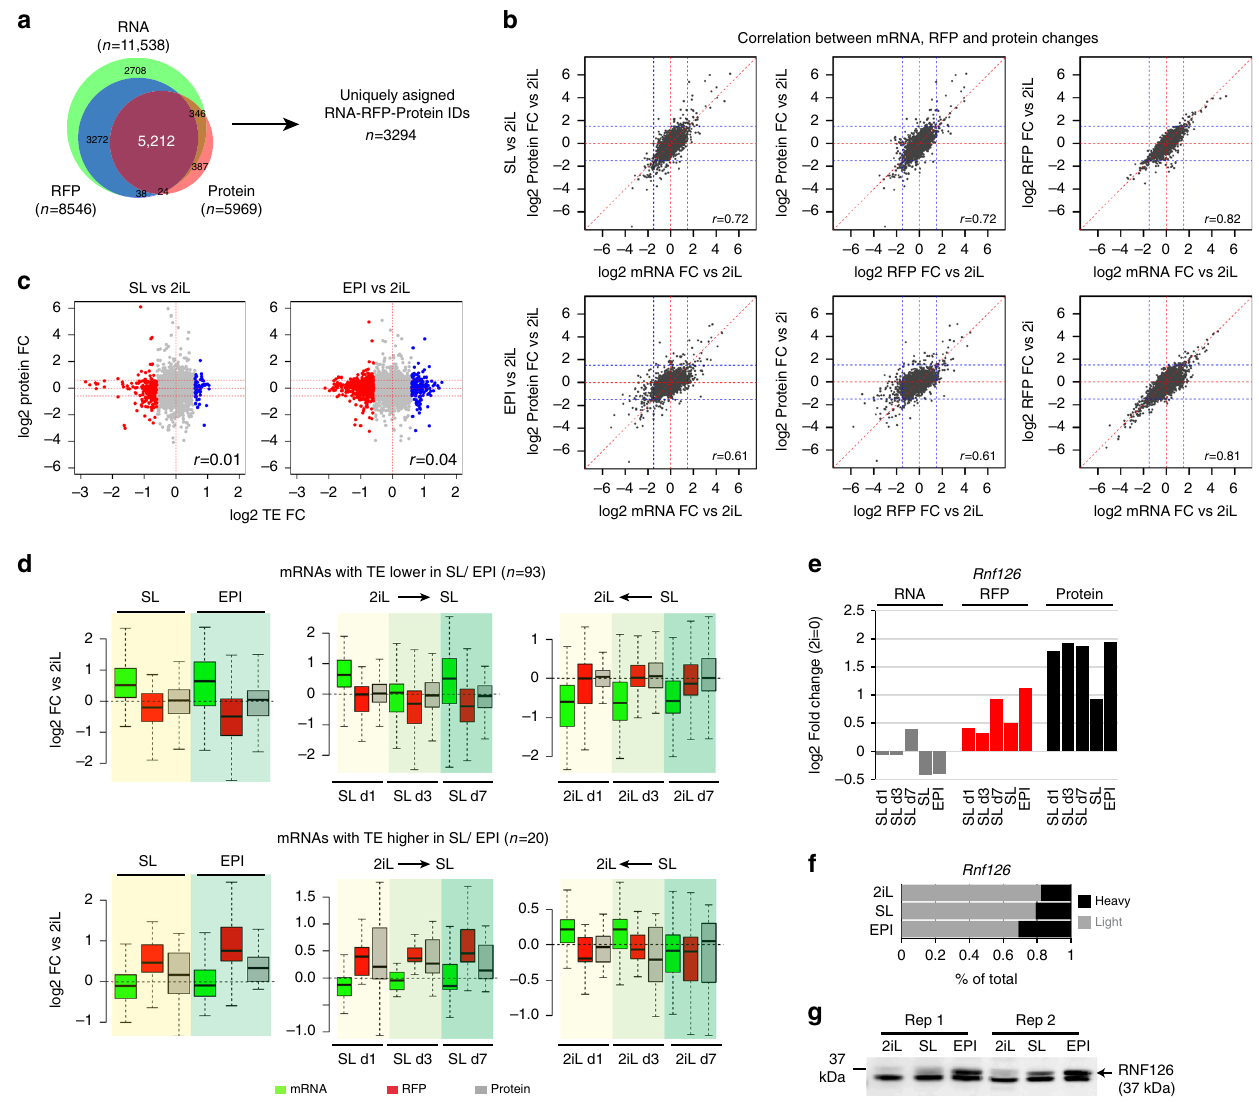
Fig. 2 Translational buffering maintains a largely stable protein expression in 2iL ESCs. a Venn diagram showing the overlap between RNAs, RFPs, and proteins detected in SL, 2iL, or EPI states. RNAs with minimum of 50 reads and RFP with minimum of 25 reads in at least one of the ES conditions were selected and intersected with the 5969 detected proteins. Only uniquely annotated proteins that could be detected in all three conditions (to allow for fold change comparison) were maintained, giving rise to n = 3294 uniquely assigned RFP – RNA – protein IDs. b Scatter plot showing the correlation between fold change in RFP, RNA, and proteins when SL or EPI are compared to 2iL state. Values represent the mean of two highly similar biological replicates. n = 3924 RFP – RNA – protein IDs. R -values represent Pearson correlation coef fi cients. c Scatter plot showing the correlation between changes in TE and protein expression when SL or EPI are compared to 2iL state. Values represent the mean of two highly similar biological replicates. n = 3924 RFP – RNA – protein IDs. r -values represent Pearson correlation coef fi cients. d Box plots showing the opposite changes in RNAs and RFPs abundances that result in maintenance of constant protein levels in different states of ESCs and during the SL-to-2iL or 2iL-to-SL transition. Box = 25 – 75th percentile; bar = median; whiskers = 5 – 95th percentile. e Bar plot showing the fold change in RNA-, RFP-, and protein-levels of Rnf126 during 2iL-to-SL transition and in EPI state. f Bar plot showing the distribution of Rnf126 mRNAs in low-density and high-density polysome fractions in different states of ESCs. The qRT-PCR values represent the mean of two highly similar biological replicates. g Western blot analysis of RNF126 in different ESC states. Two biological replicates were used per Proteome changes are accompanied by transcriptional rewir- Principal component analysis con fi rmed the largely similar ing . Since variation in protein levels is the key determinant of trajectories of mRNA and protein dynamics during the 2iL to SL gene expression and as the vast majority of changes in protein and EPI transition (Fig. 3a ) . Among the 4743 identi fi ed protein expression could not be explained by translational control, we groups, 26% ( n = 1250 proteins) showed differential expression next sought to further characterize the differential protein in at least one time point of the 2iL to SL to EPI transition (fold expression during naive to primed ESC transition. The quanti- change ≥ 3 and FDR < 0.05). When the steady states were tative information obtained at different layers of gene expression compared, 7% ( n = 338) were differentially expressed between and at different time points of naive to primed ESC transition SL and 2iL and 6% ( n = 293) between EPI and 2iL (Fig. 3a, b). provided a unique opportunity to investigate how the proteome Among the proteins that are differentially expressed in 2iL vs. SL rewiring takes place in different states of pluripotency. or EPI ( n = 465), 216 proteins were exclusive to certain ESC state